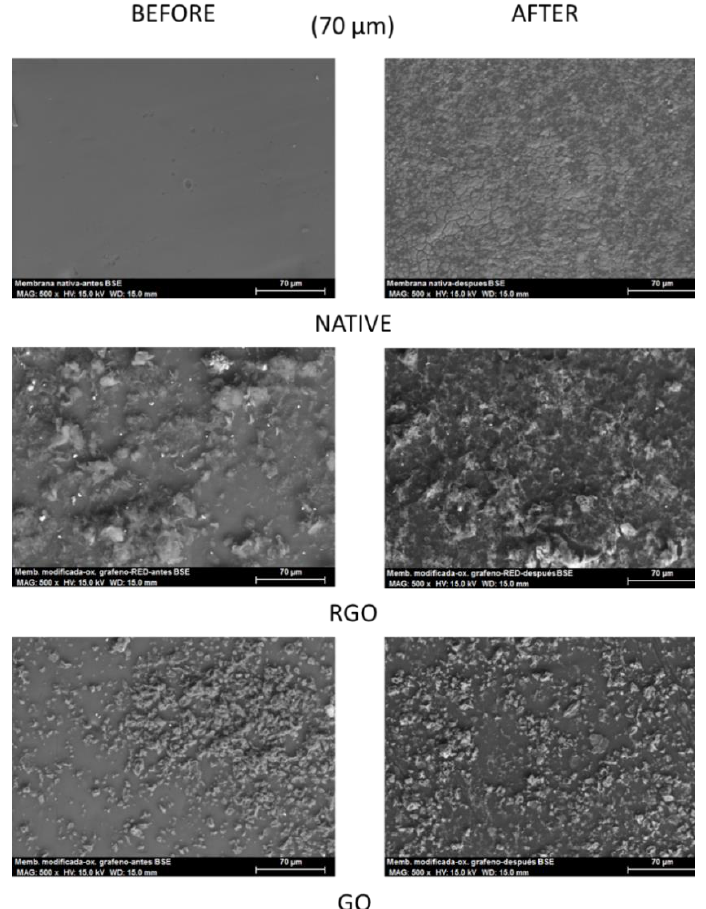
Figure 1. SEM images of the membranes (native and modified).